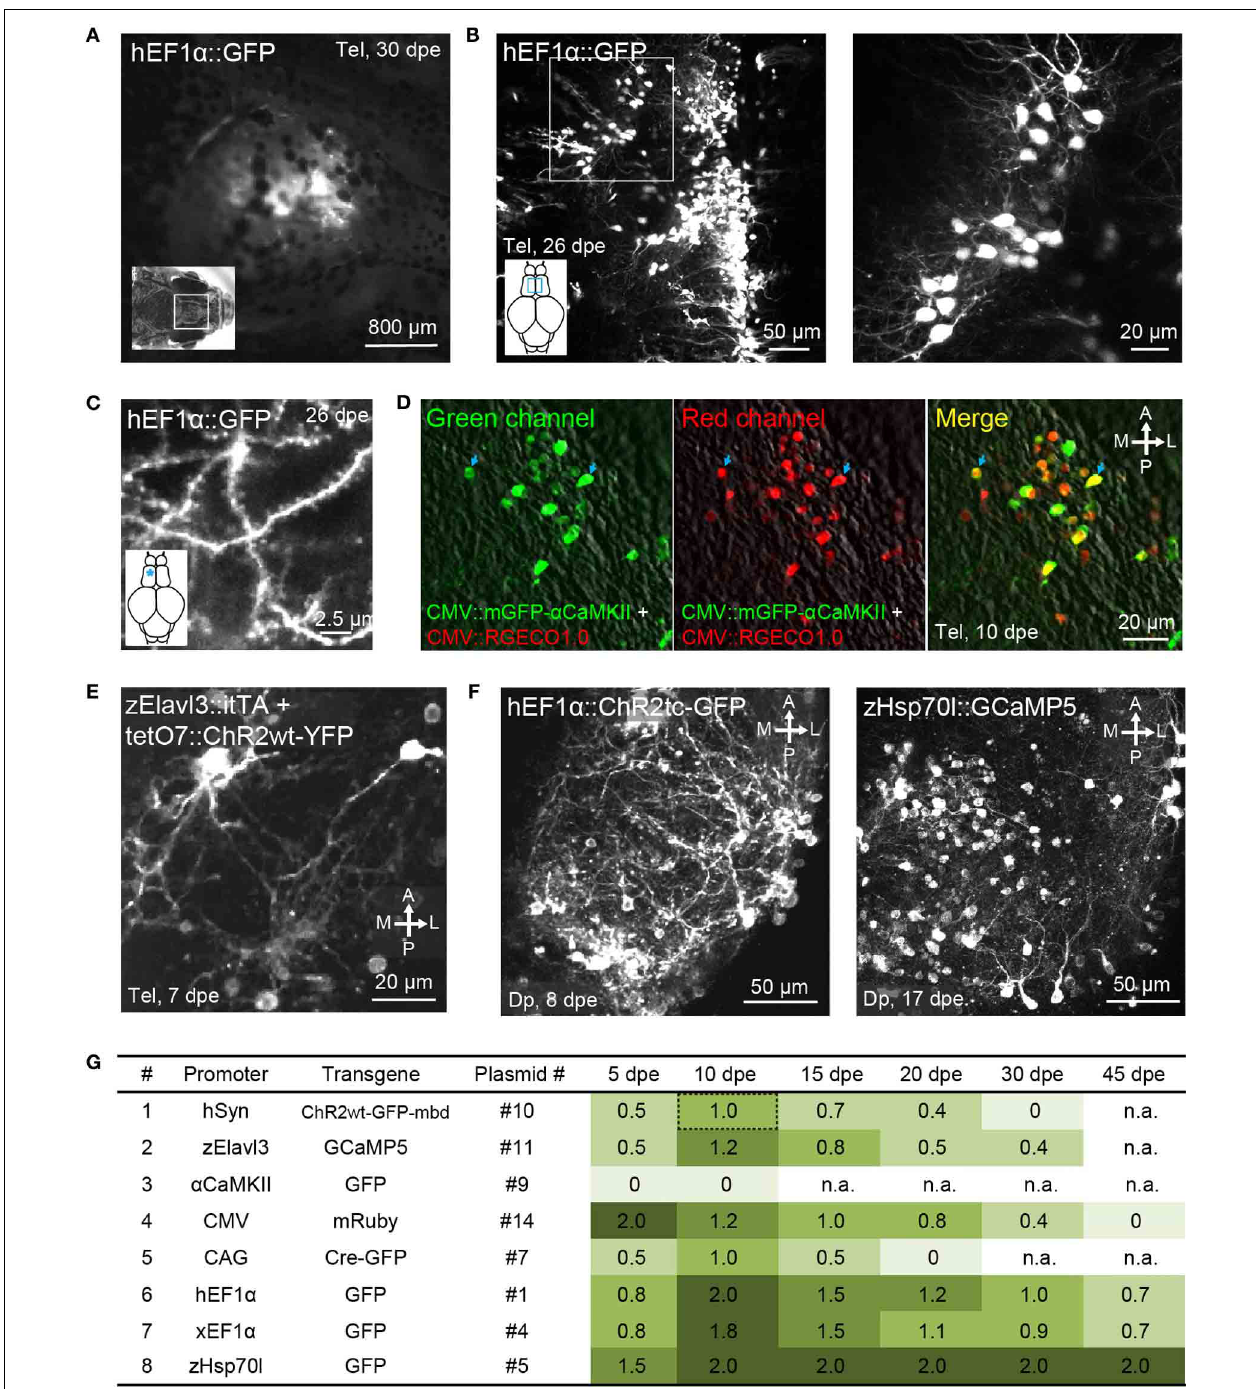
FIGURE 3 | Gene expression in the adult zebrafish brain using electroporation. (A) Fluorescence image of the dorsal head of an adult zebrafish 30 days after electroporation (dpe) of plasmid #1 (EEP; hEF1 α ::GFP). Image was taken with a fluorescence stereomicroscope. (B) Expression of GFP in the dorsal telencephalon after electroporation of plasmid #1 (EEP; z -projection of multiphoton image stack). Boxed area is shown at higher magnification on the right. (C) GFP expression in spiny dendrites (same fish as in B ; location is indicated by asterisk). (D) Expression